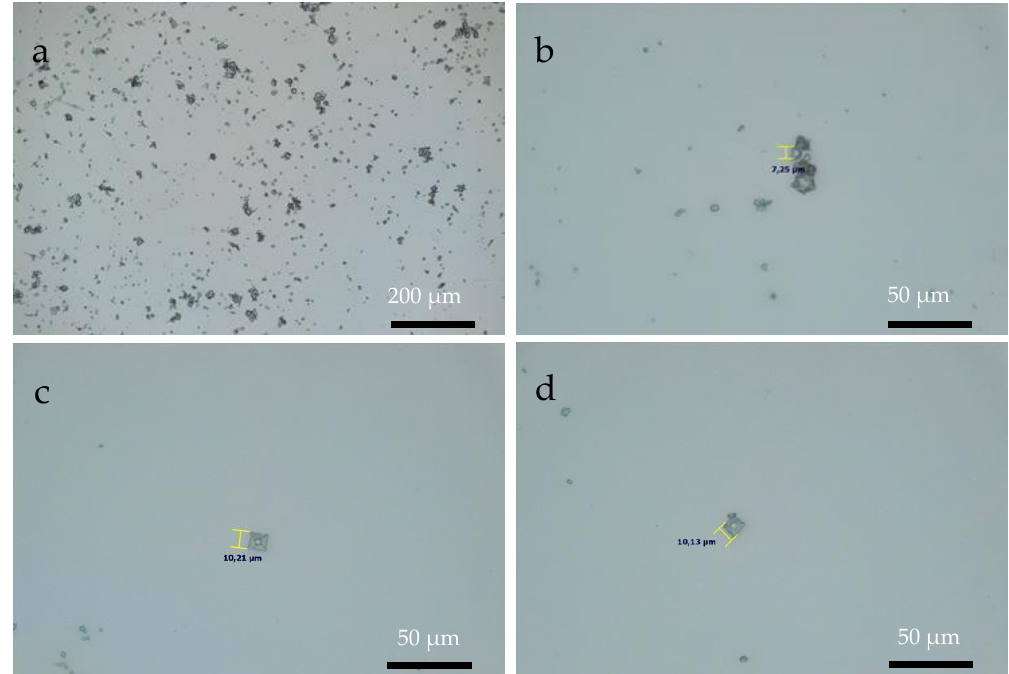
Figure 6. OM images of CaOx crystals obtained on ITO substrate at ( a ) 10× and ( b – d ) 40× magnifications.